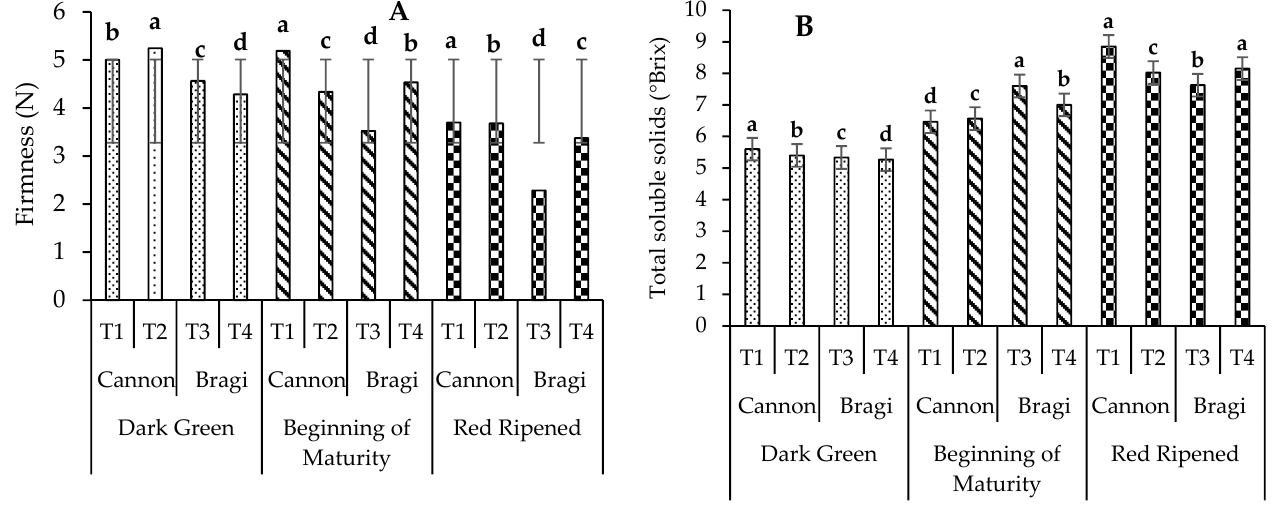
Figure 1. Variation in firmness ( A ) and total soluble solids ( B ) at different ripening stages in greenhouse-grown bell pepper. Different letters on each bars indicate significant differences ( p ≤ 0.05).